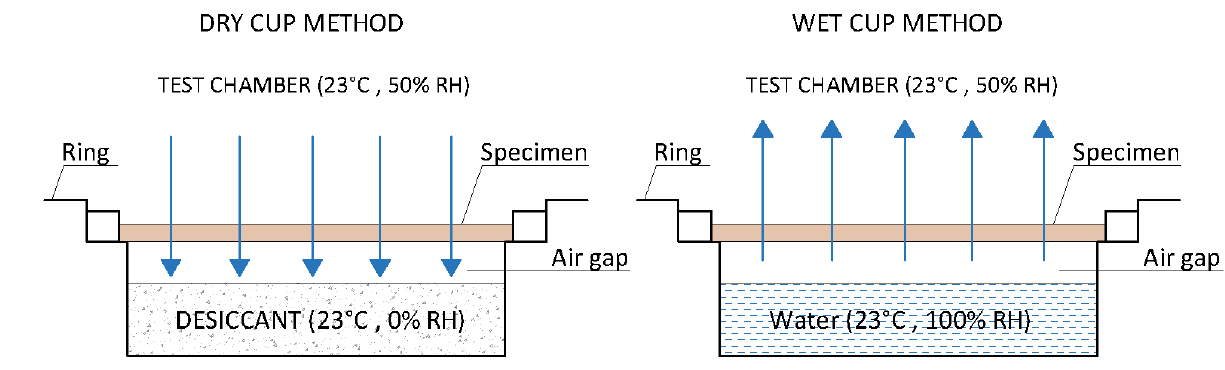
Figure 2. The scheme of dry and wet cup methods.